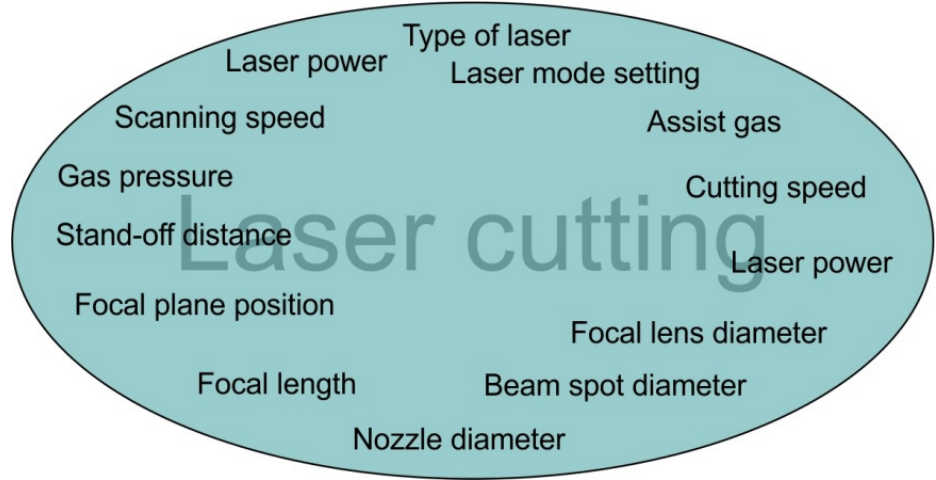
Figure 1. Critical laser cutting parameters.